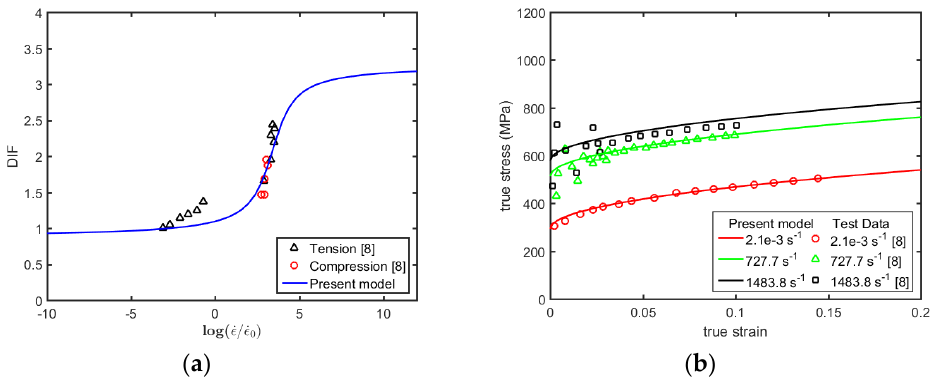
Figure 7. Comparison of the present model with the test data for Q235 mild steel. ( a ) DIF versus strain rate at yield stress in tension and compression at room temperature; and ( b ) true tress-true strain curves in compression.